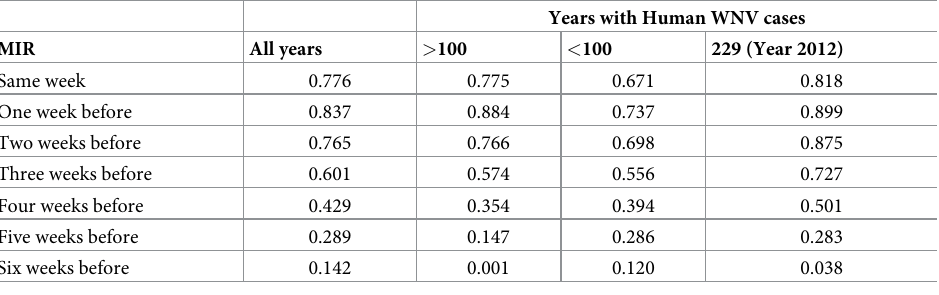
Table 3. Spearman correlation of weekly cumulative human WNV cases and lagged MIR for all years and selected subsets of years from 2005–2016 in Cook and DuPage counties. Years with Human WNV